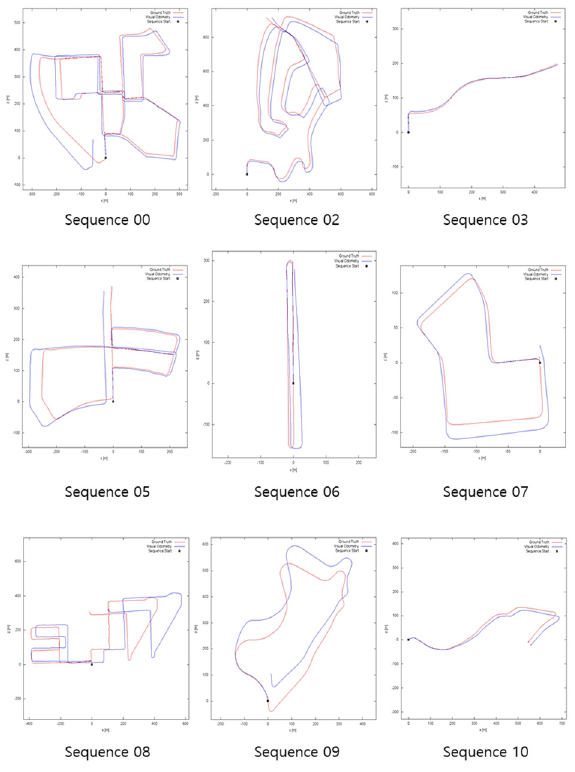
Figure 9. Estimated trajectory by relative orientation The next is the result of applying relative orientation and scale calibration to visual odometry. Figure 9 shows the experimental results for sequence 00 of KITTI data. The red line represents the true value, and the blue line is the estimation result. As a result of the experiment in 9 sequences, an average rotation error of 0.05 degree per meter occurred. In the case of translation, the error rate was 5.46%.